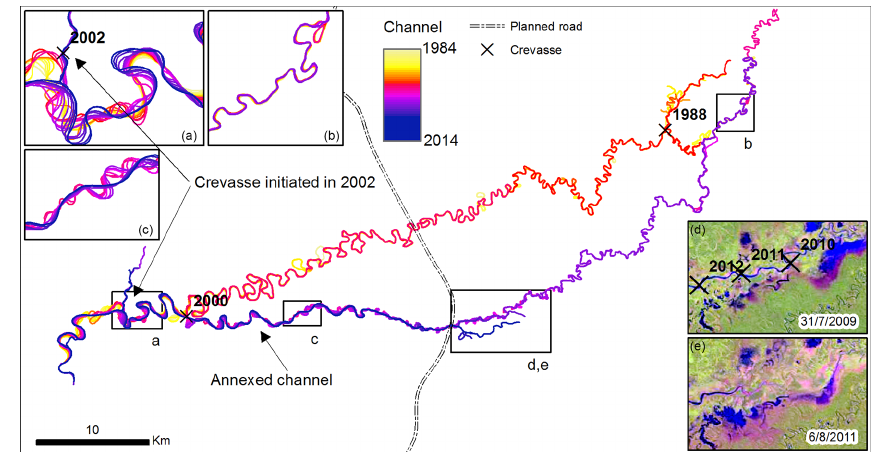
Figure 6. Avulsions of the Río Moleto. The channel annexed in the year 2000 adjusted the upper part of its course (c) , but is unable to carry the total flow in the middle part of the channel, where several crevasses have opened up, causing the collapse of the channel and the deposition of the sedimentary load (d, e) . A crevasse initiated in 2002, upstream from the current diversion site (a) , and is leading to a process of avulsion that could be completed in the next decade. Reddish areas in the Landsat images of insets d and e show dead forest due to waterlogging. See location in Fig. 1.